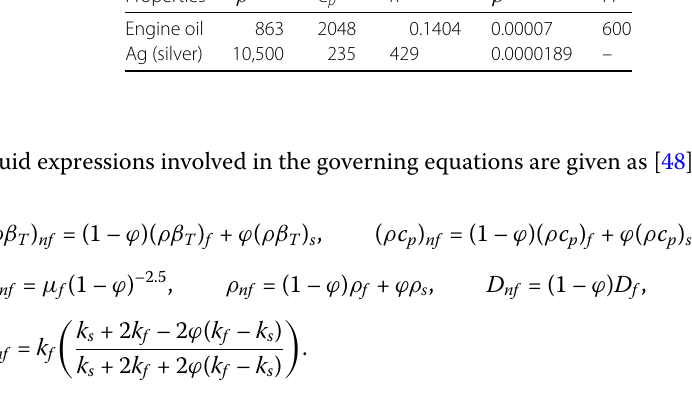
Table 1 The thermo-physical properties of the base fluid and nanosized particles Properties ρ C p K β Pr Engine oil 863 2048 0.1404 0.00007 600 Ag (silver) 10,500 235 429